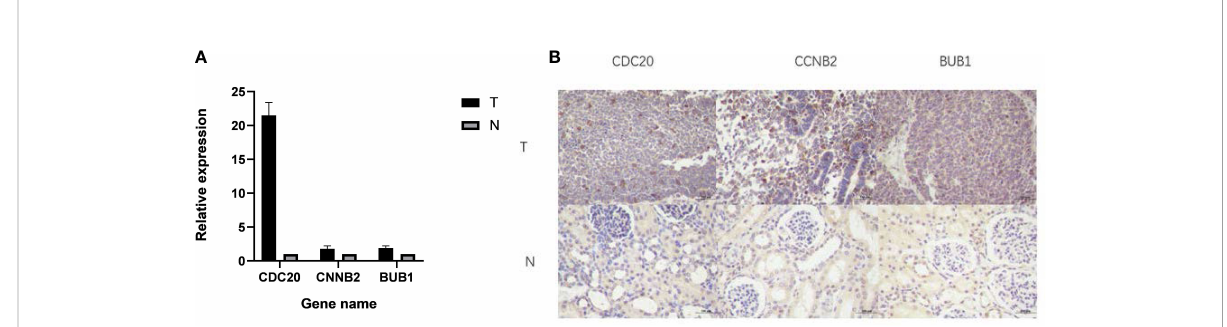
FIGURE 4 CDC20, CCNB2 and BUB1 are highly expressed in tumor tissue. (A) Expression levels of CDC20, CNNB2 and BUB1 mRNA determined by real- time PCR in Wilms tumor (T) and normal (N) tissues. (B) Expression levels of CDC20,CNNB2 and BUB1 protein determined by IHC in Wilms tumor (T) and normal (N)